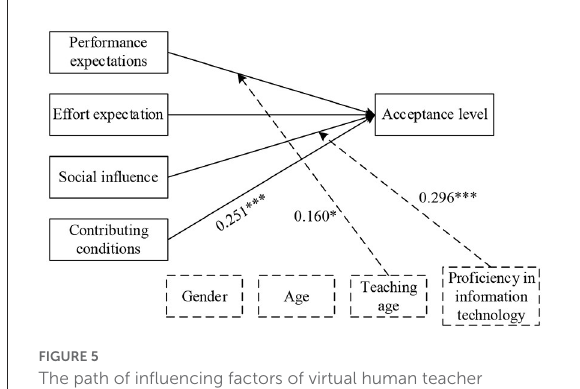
FIGURE5 The path of influencing factors of virtual human teacher education